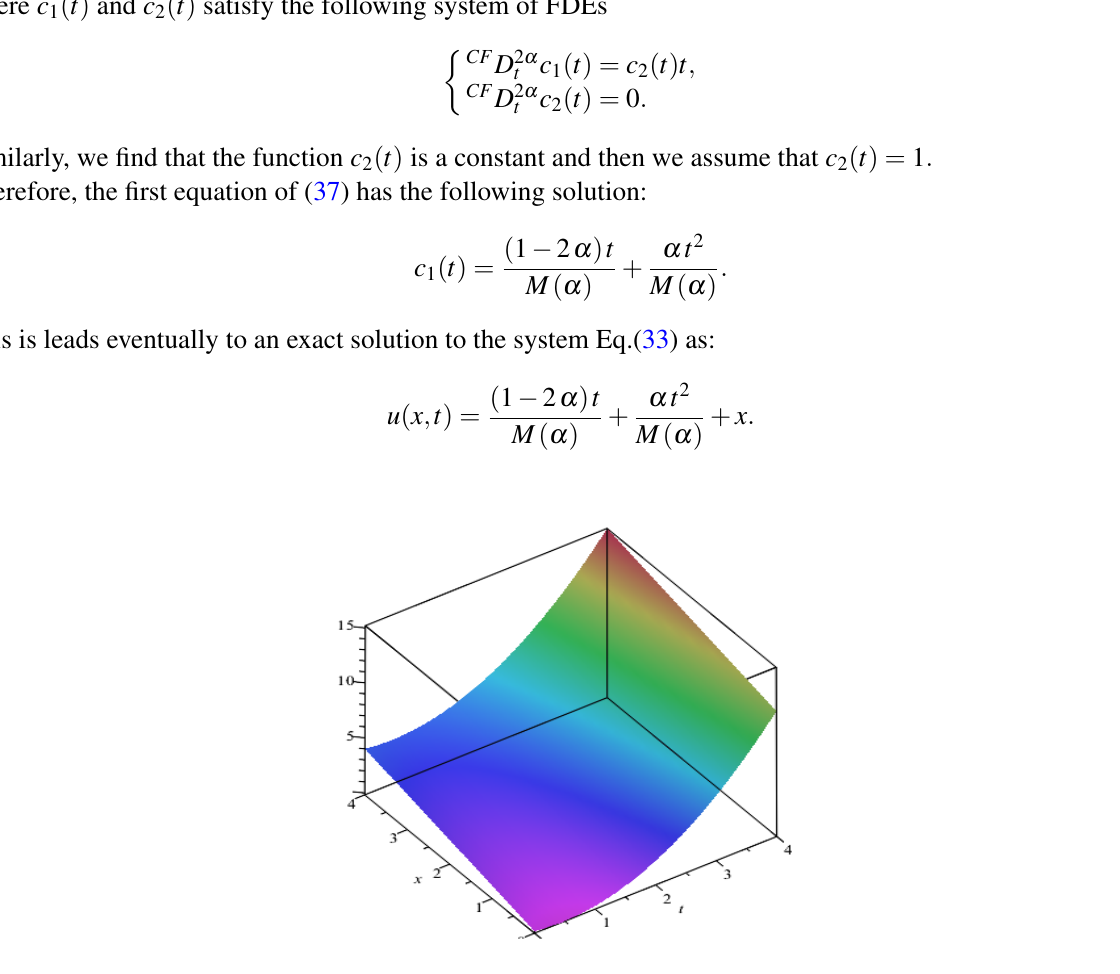
Fig. 4 Profile of the solution (39) for α = 0 . 9